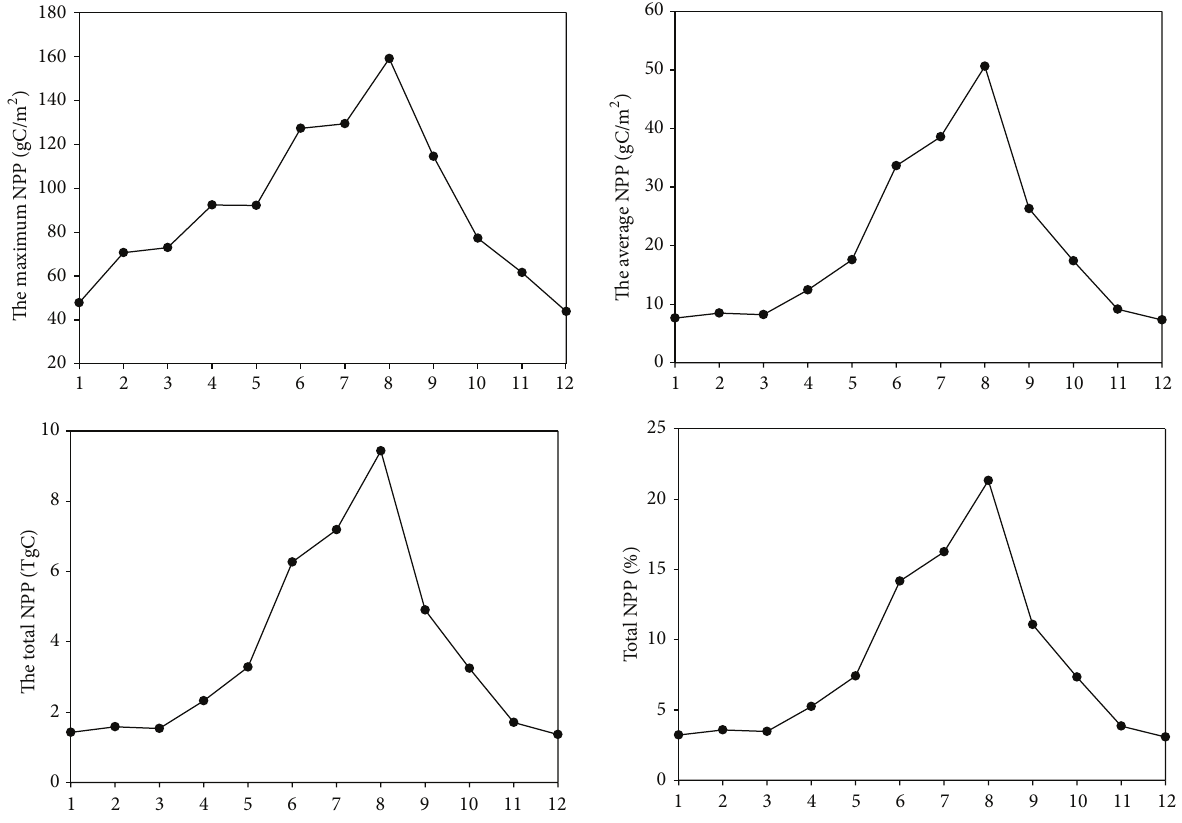
Figure 9: Monthly variation of NPP in